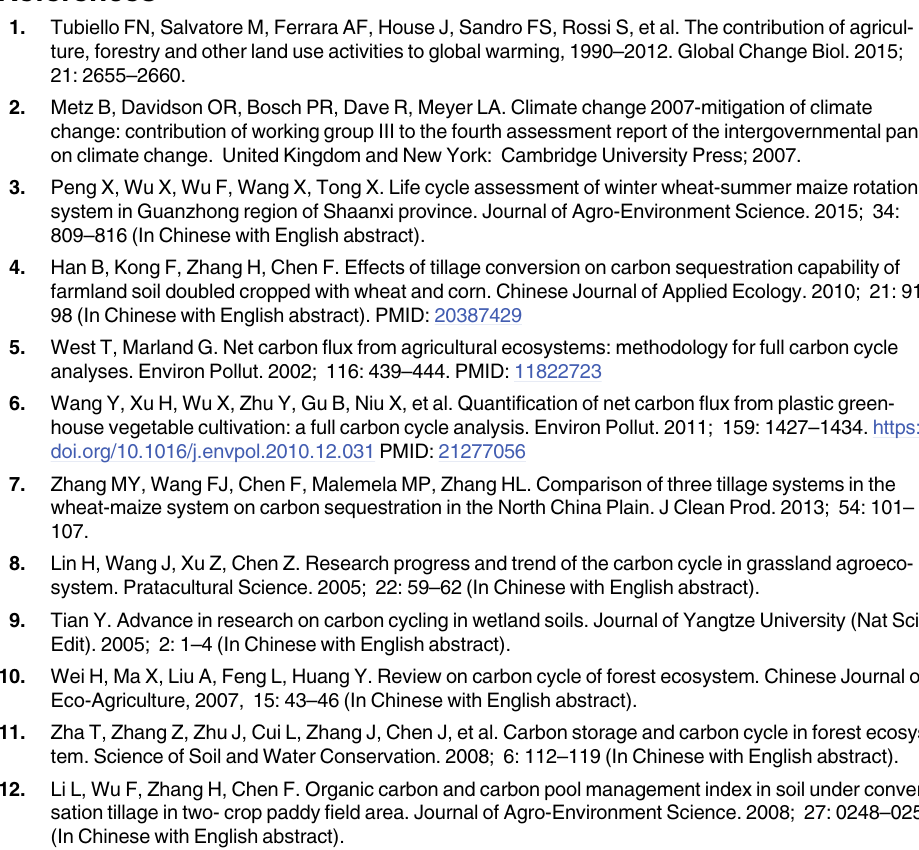
S6 Table. The agro-ecosystem C balance (NCF) and its main components for the annual cycle of wheat-maize rotation in 2013–2015. S7 Table. The carbon productivity under different